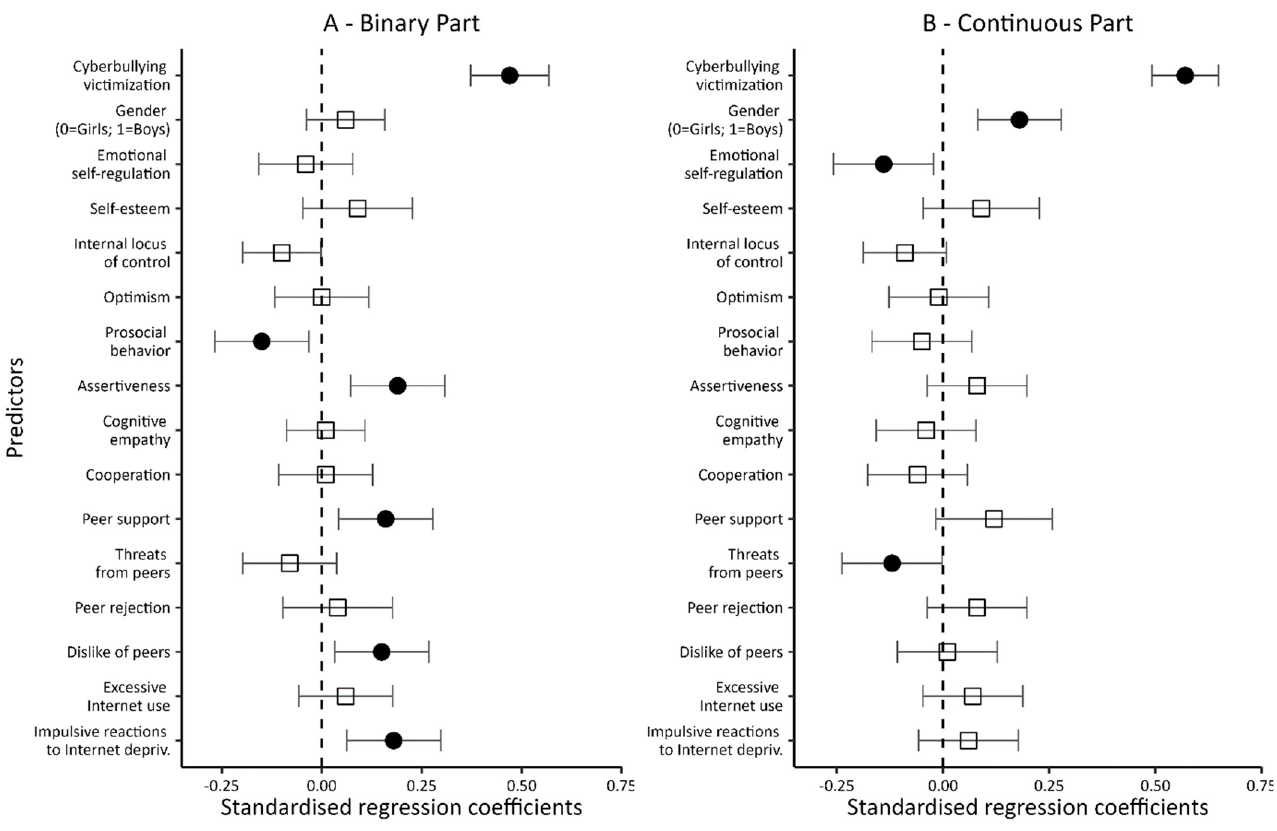
Figure 6. Model 4. Standardised regression coefficients with 95% confidence intervals. Note: Black circle-coefficient significant at 0.05; white square-coefficient insignificant ( p > 0.05); tails = standard errors.